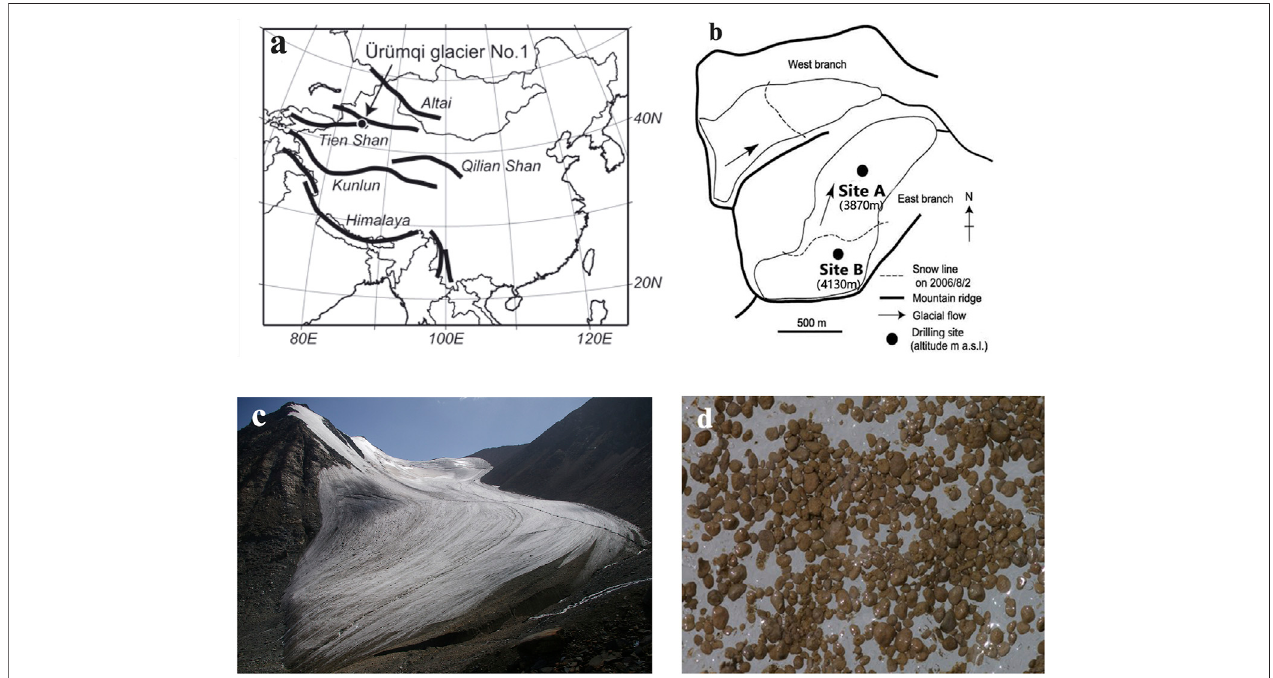
FIGURE 1 | Location maps and photographs of Urumqi Glacier No.1. (A) Location of Urumqi Glacier No.1 in the Tienshan Mountains. (B) Map of Urumqi Glacier No.1 showing drilling sites of the ice cores used in this study. (C) The east branch of Urumqi Glacier No.1 in August 2010. (D) The bare ice surface covered with cryoconite of Urumqi glacier No.1 near the drilling site of Core